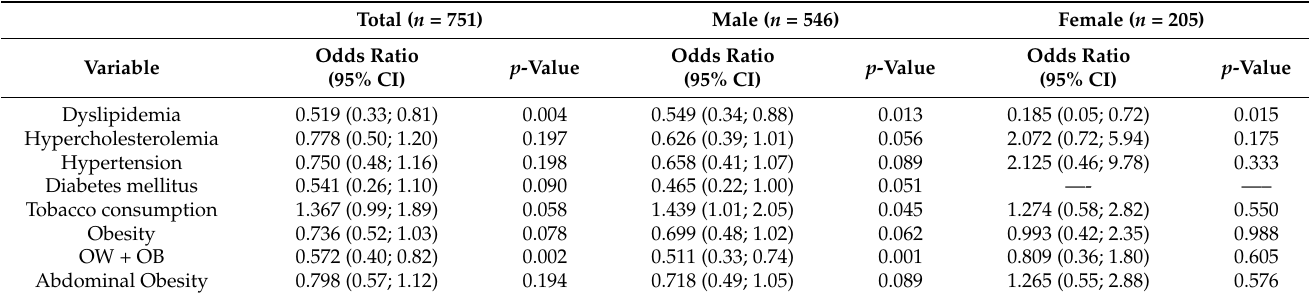
Table 4. Association between occupational physical activity (OPA) and cardiometabolic risk condi-